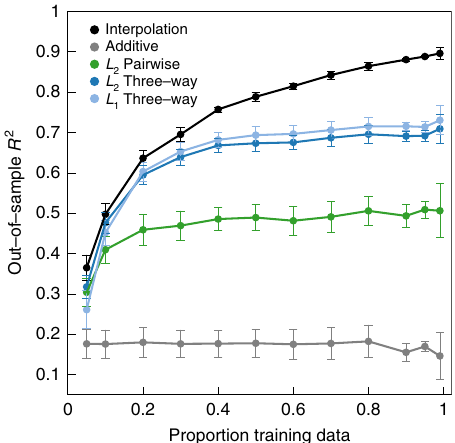
Fig. 3 Model performance for the simulated sparse random interaction landscape with all orders of epistasis ( l = 7, α = 4). L 2 -regularized pairwise and three-way regression models and L 1 -regularized three-way model were fi t with regularization parameters chosen by 10-fold cross- validation. Predictive power (out-of-sample R 2 ) is plotted as a function of the proportion of in-sample genotypes assigned as the training data. Error bars indicate one standard error around the mean, n =